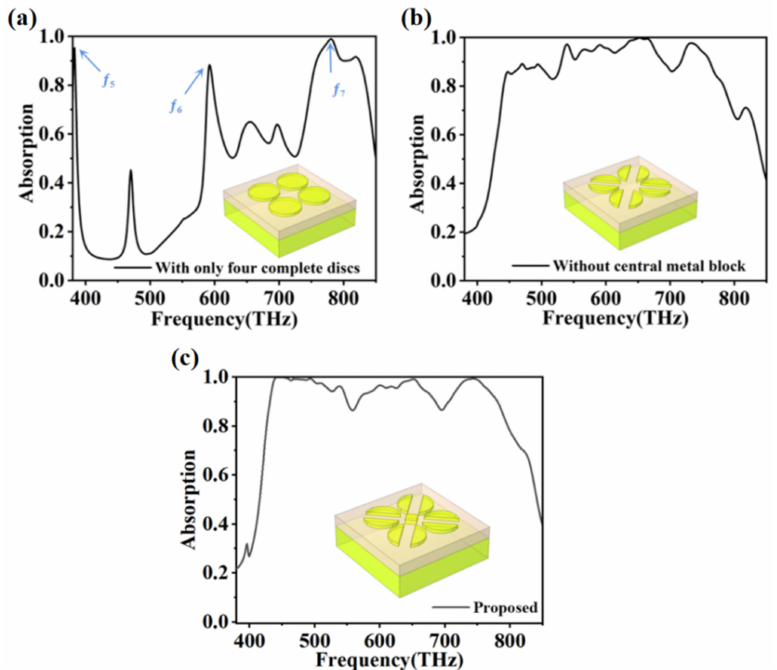
Figure 4. ( a ) Absorption spectrum of the absorber with only four complete disks. ( b ) Absorption curve of the absorber without a central metal block. ( c ) Absorption curve of the structure proposed in this paper.